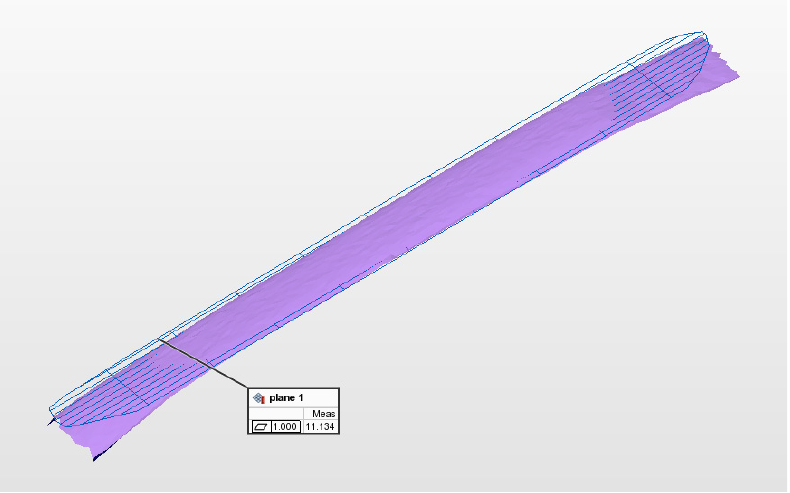
Figure 11. Triangular surface slice results of ceramic plane point cloud.